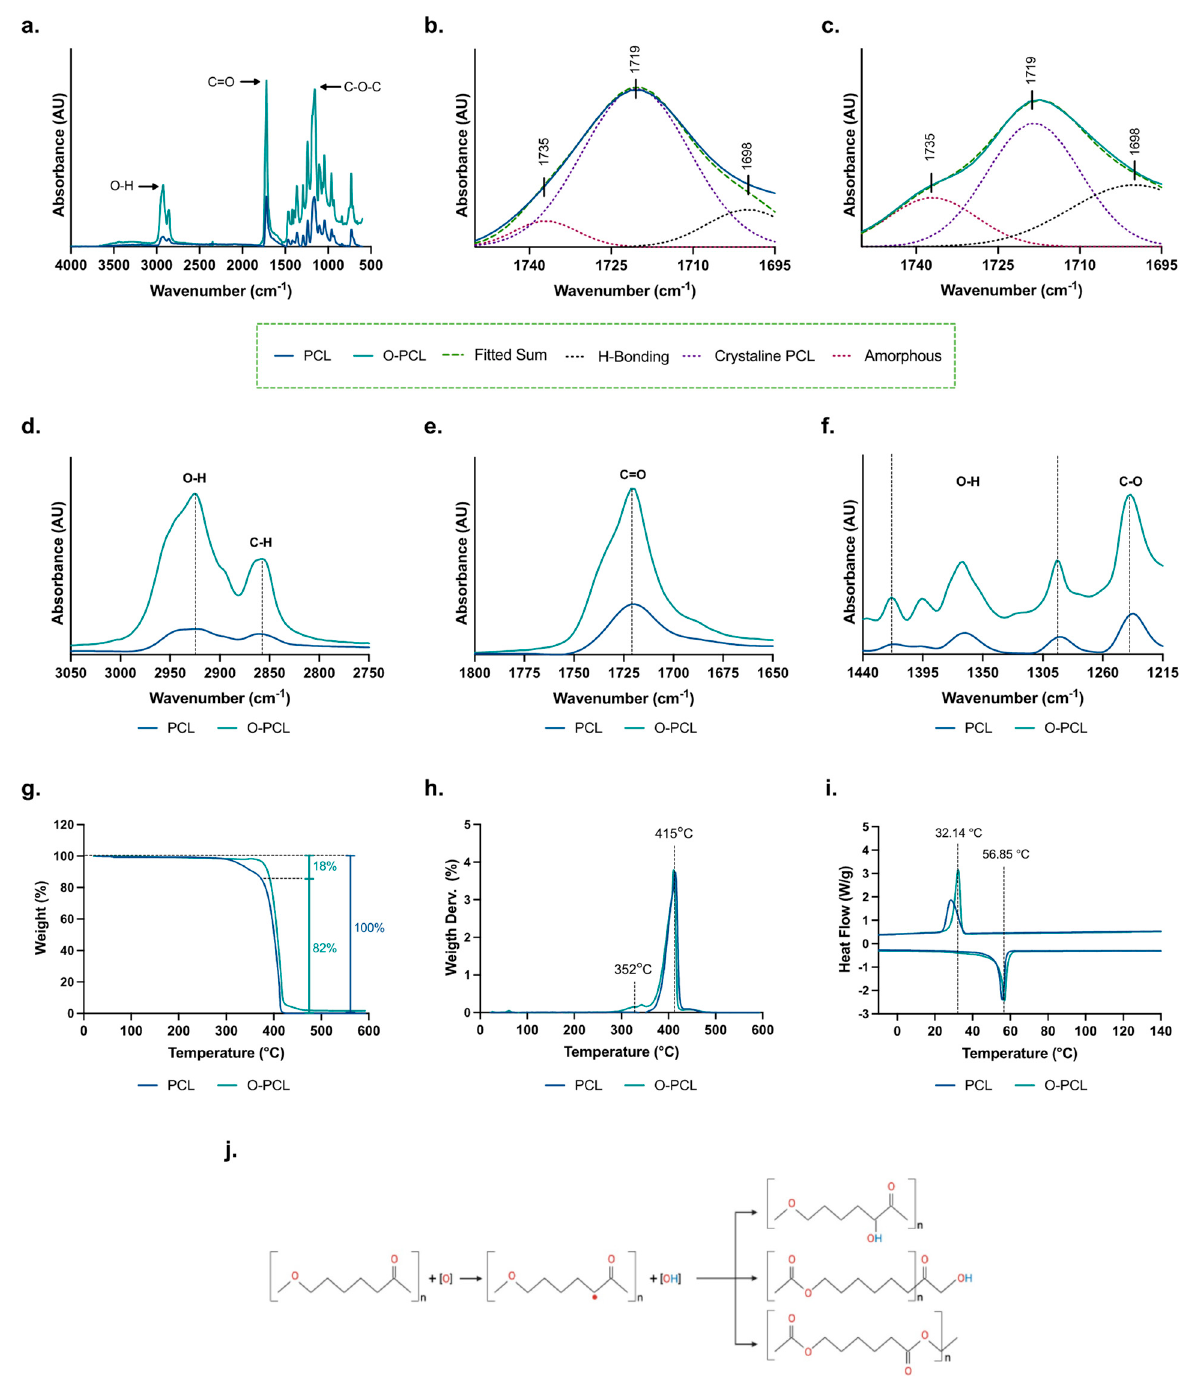
Figure 2. Evidence of PCL oxidation. ( a ) FTIR spectra of PCL and O-PCL measured in the range between 4000 to 600 cm − 1 . Deconvolution analysis of carbonyl (C=O) stretching via Gaussian profiles of ( b ) PCL and ( c ) O-PCL. Maximum absorbance of the deconvoluted curves is indicated in the figure. AU stands for arbitrary units. Magnification of the ( d ) hydroxyl (-OH) and carbon-hydrogen (-CH) stretching, ( e ) carbonyl (C=O) stretching, and ( f ) carbon-hydrogen (-CH) and carbon-oxygen bending (-CO), present in pristine PCL and the O-PCL because of an increased level of oxygen-containing functional groups. ( g ) Thermogravimetric (TGA) analysis and ( h ) DTGA curves of PCL and O-PCL. ( i ) DSC thermograms for pristine PCL and O-PCL. ( j ) Possible outcomes of the PCL oxidation process.